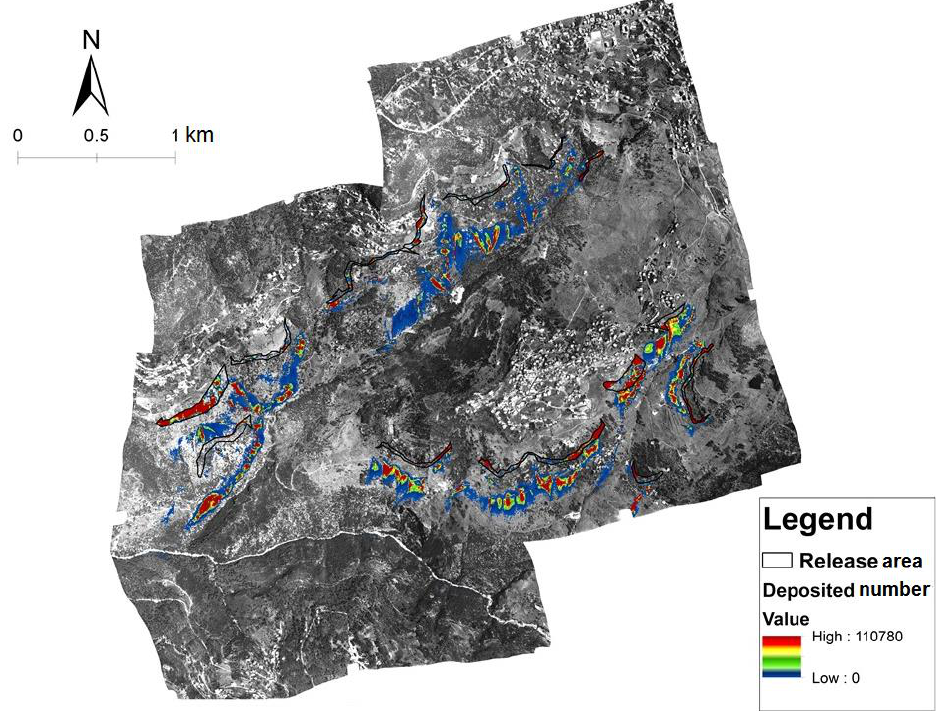
Figure 9. The obtained deposited number of rocks after 1000 simulations for the worst case scenario: earthquake with magnitude 7.